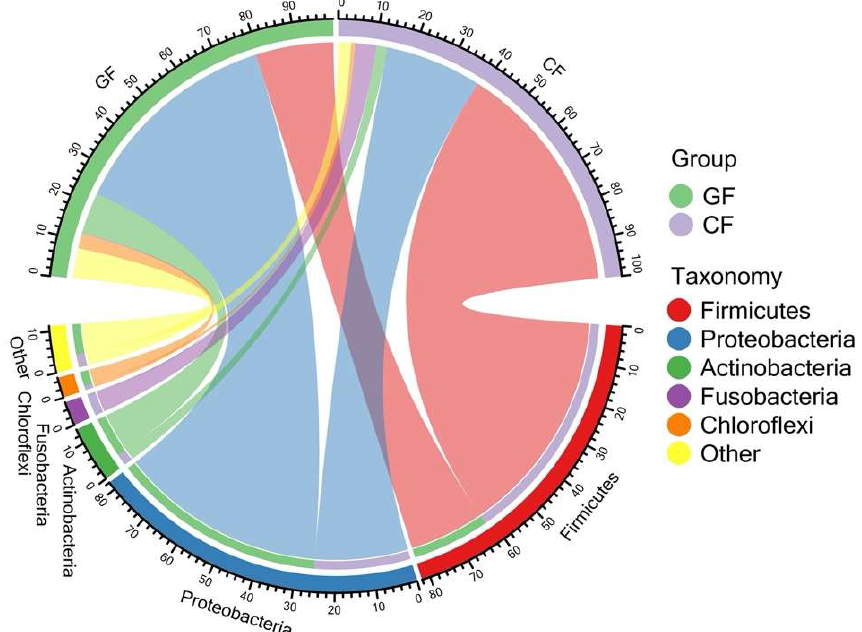
Figure 1. Chord diagram exhibited the relative abundance of bacterial phyla above ≥ a cutoff value of 2%.